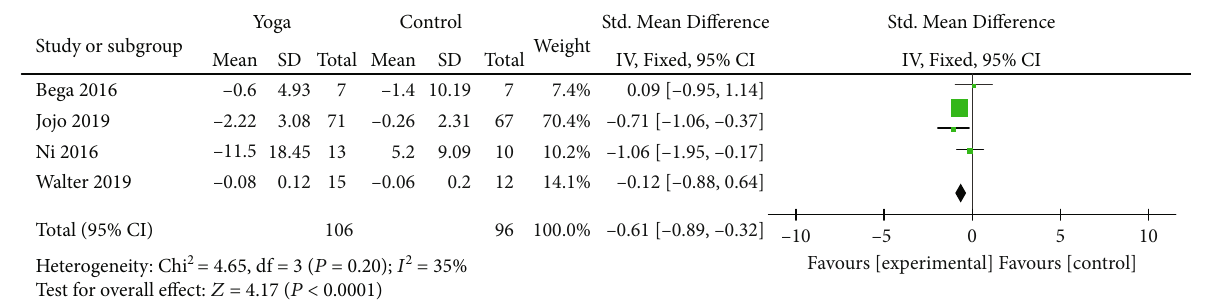
Figure 9: Forest plot from the meta-analysis of yoga on quality of life.